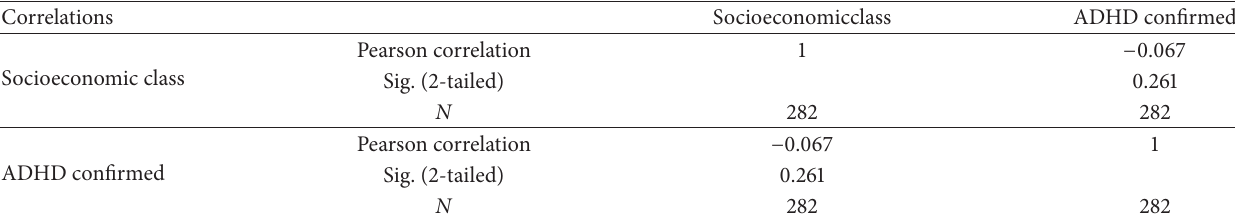
Table 3: Correlation between socioeconomic class and